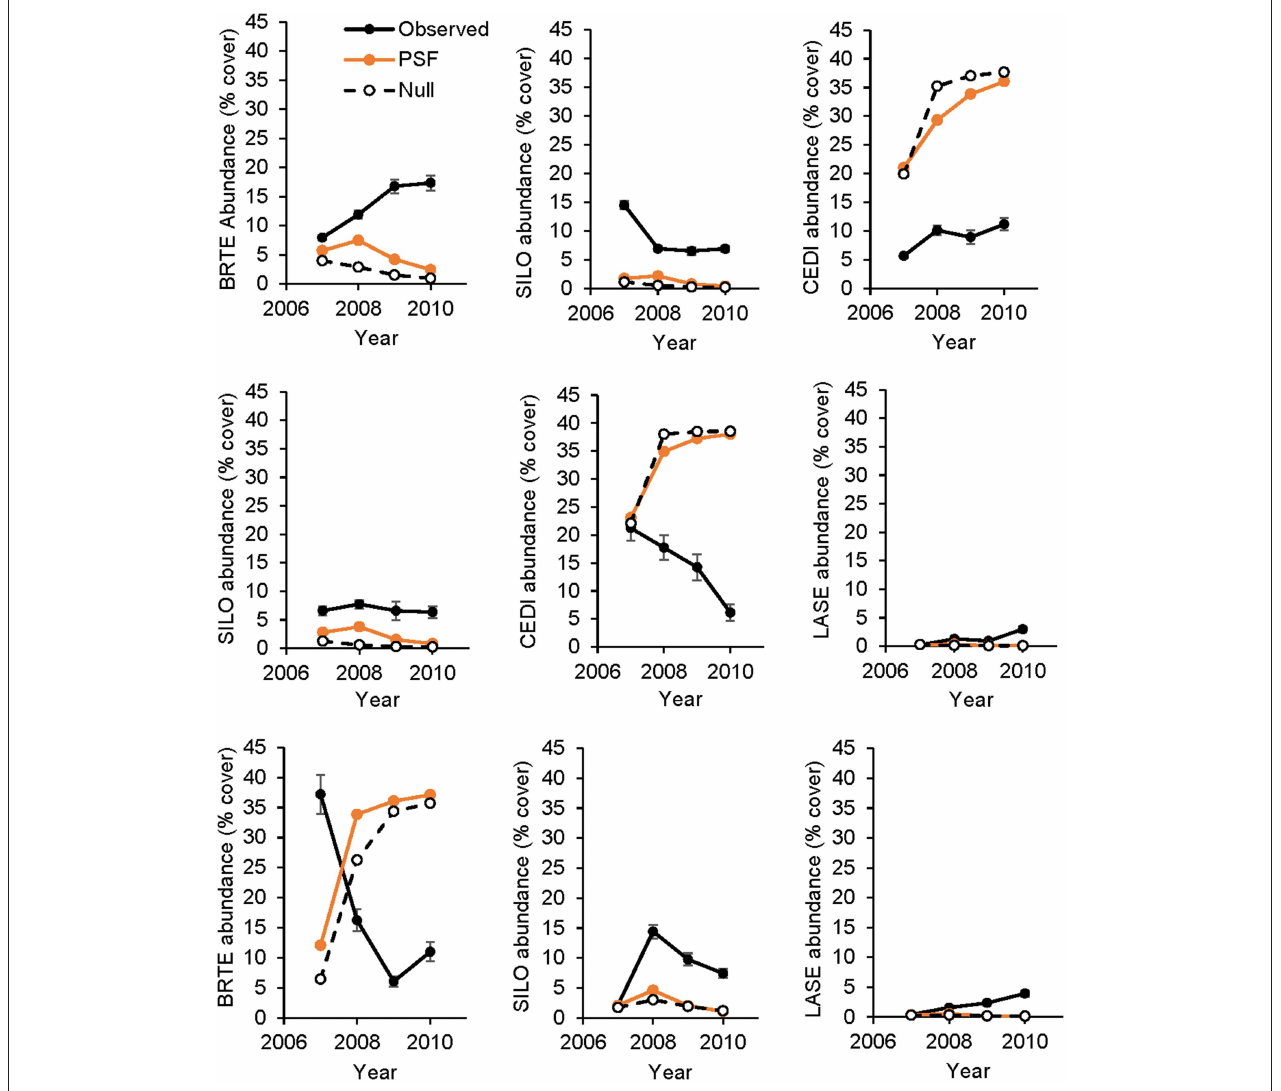
FIGURE 4 | Observed and predicted abundance of non-native plant species in three-species experimental plant communities over time. Species in a row are from the same three-species community. Model predictions were made either with plant-soil feedback effects (PSF) or without plant-soil feedback effects (Null). BRTE, Bromus tectorum ; CEDI, Centaurea diffusa ; SILO, Syssymbrium loeselii ; LASE, Lactuca serriola